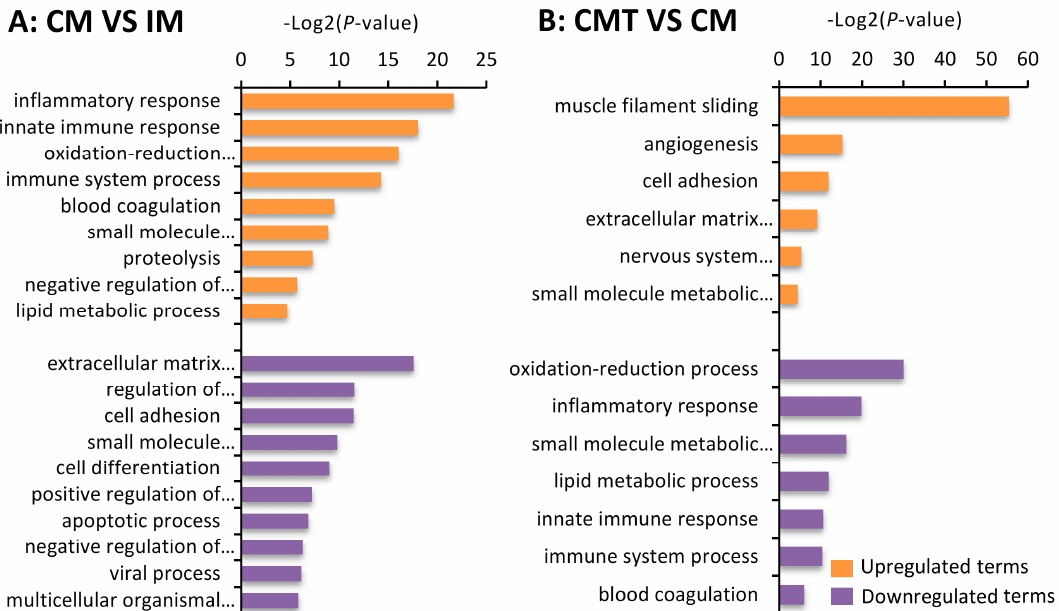
Figure 3. Gene ontology (GO) analysis of differentially expressed genes (DEGs) between groups: ( A ) GO terms associated with the DEGs between CM versus IM; and ( B ) GO terms associated with the DEGs between CMT versus CM. IM: intact male pigs fed a HFC diet; CM: castrated male pigs fed a HFC diet; CMT: castrated pigs with testosterone replacement fed a HFC diet.